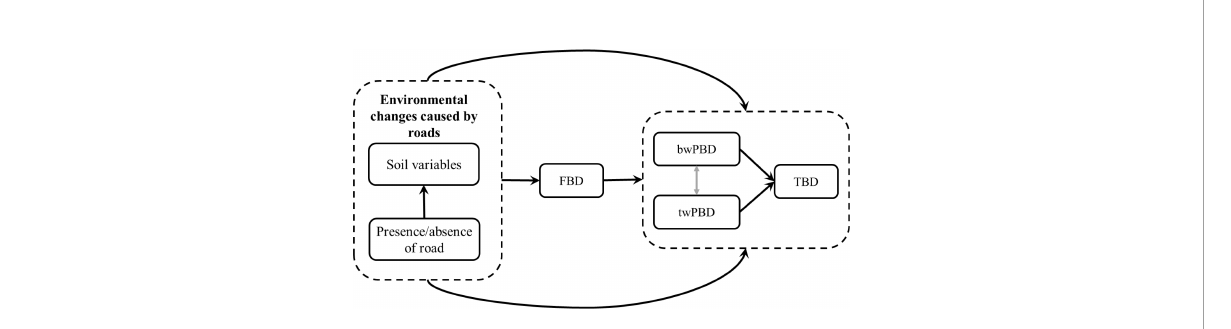
FIGURE 2 A causal framework, including the presence/absence of mountain roads, change in soil variables and the three facets of beta diversity. Arrows indicate the direction of causality. TBD, taxonomic beta diversity; FBD, functional beta diversity; bwPBD, basal-weighted phylogenetic beta diversity; twPBD, tip-weighted phylogenetic beta diversity.